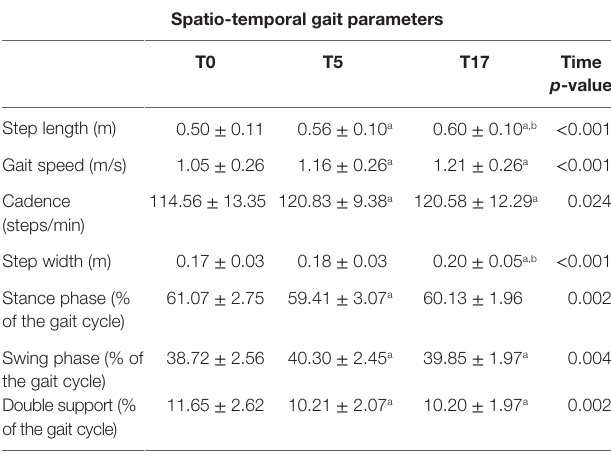
Table 2 | comparison between spatio-temporal parameters assessed before and after rehabilitation.